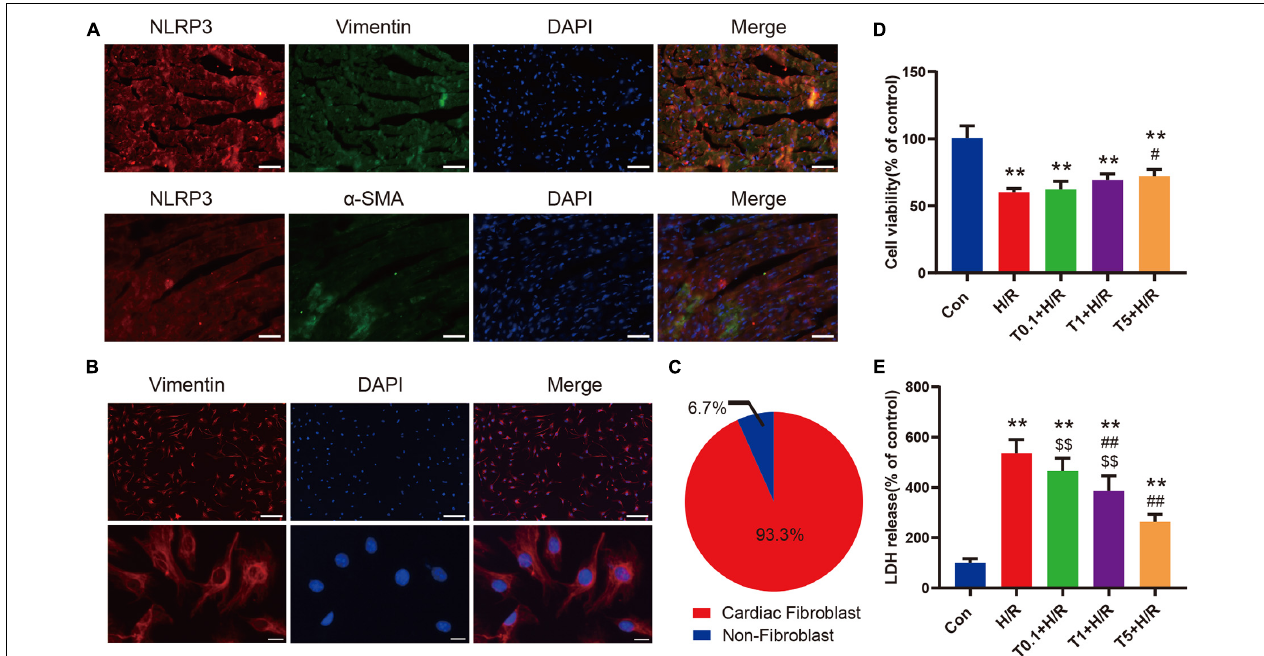
FIGURE 6 | Iguratimod attenuated cell injury of primary CFs exposed to H/R condition. (A) Double-immunofluorescence staining with antibodies against NLRP3 (red) and vimentin (green) or α -SMA (green) for left ventricular myocardium tissue. Scale bar = 50 µ m. (B) Representative images of primary CFs isolated from hearts of neonatal mice. Scale bar of the first row = 50 µ m and scale bar of the second row = 5 µ m. (C) The purity of primary CFs in the present study. (D) Cell viability of primary CFs in Con, H/R and Iguratimod (0.1, 1, 5 µ M, respectively) pretreatment + H/R group. n = 5. (E) Percentage of LDH release in cell culture supernatants among the five groups. n = 6. Data are expressed as mean ± SD; ** p < 0.01 versus Con group; # p < 0.05, ## p < 0.01 versus H/R group; $$ p < 0.01 versus T5 + H/R group. CFs, cardiac fibroblasts; H/R, hypoxia/reoxygenation; α -SMA, α -smooth muscle actin; LDH: lactate